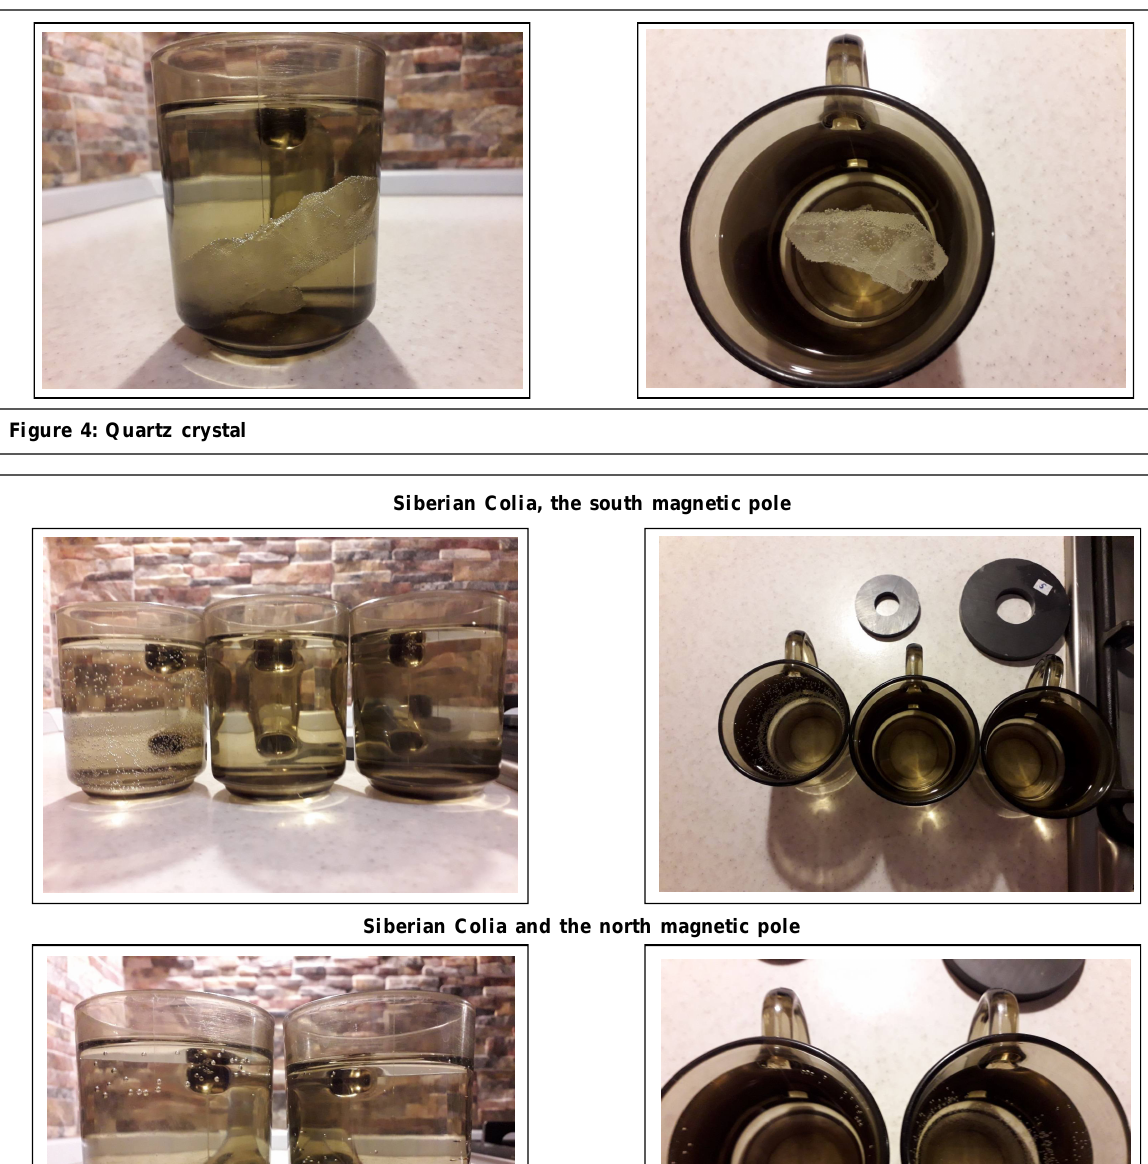
Water refill (control sample and the south magnetic